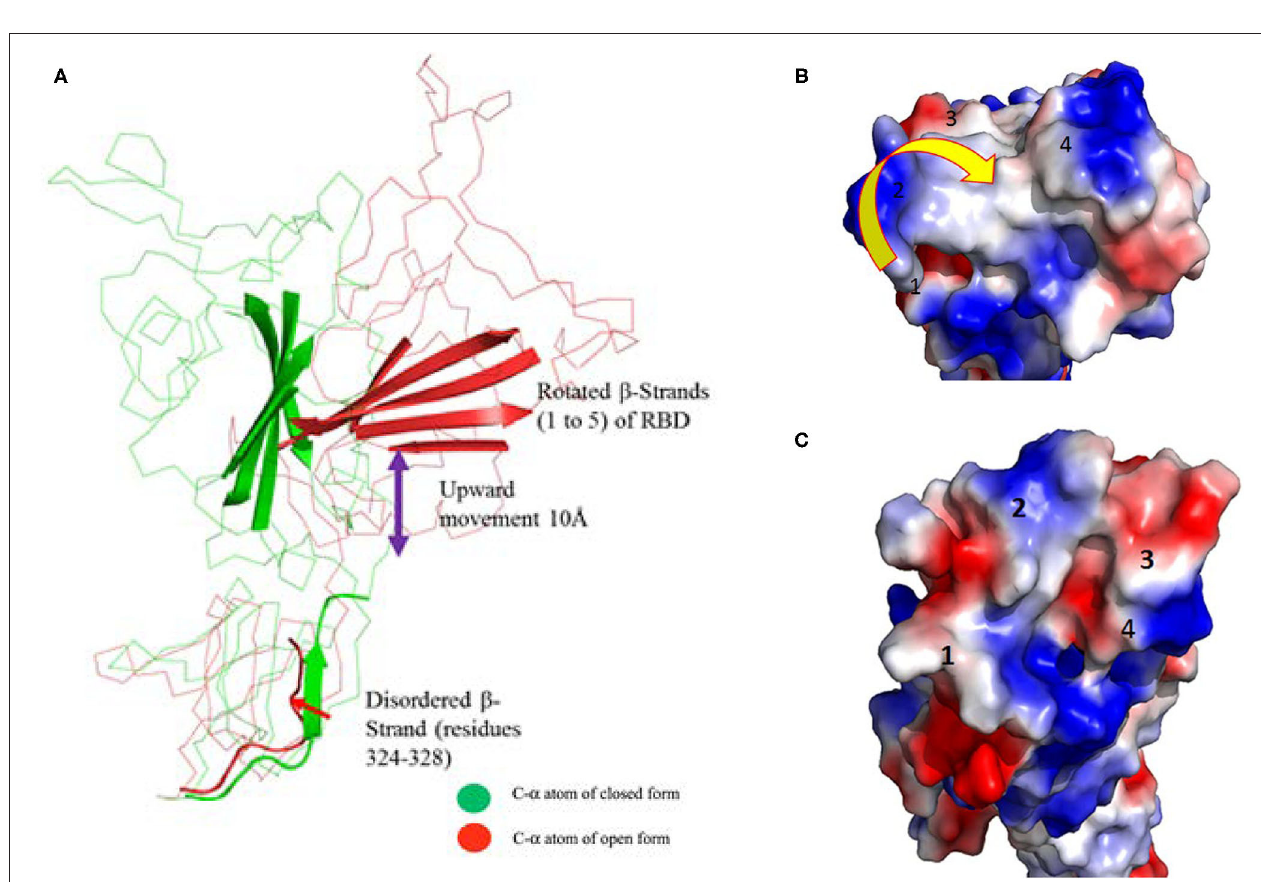
FIGURE 2 | (A) Cartoon diagram shows that residues 324–328 form a loop instead of β -strand in open conformation. This cartoon representation shows the β -strands of RBD domain movements during the conformational change. The figure also shows that during open conformation the entire domain moves 10 Å upwards (shown by blue arrow) and β -strands rotational angles changes from 75 to 110 ◦ (see Table 1 for detail information). Color code: Green-closed form and Red-open form. (B,C) Electropotential surface of the RBD for closed and open conformations, respectively. It also shows structural rearrangement leads to change in the electropotential surface, which are highlighted by numbers (1 to 4). The rearrangements occur at clockwise direction during structural change. Right side top figure is for closed form and bottom is for open form.